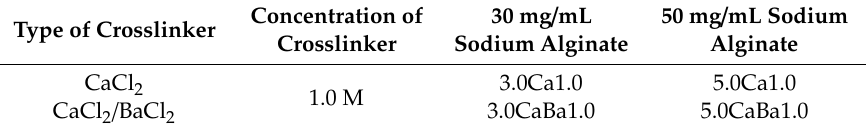
Table 2. Type and name of prepared materials based on sodium